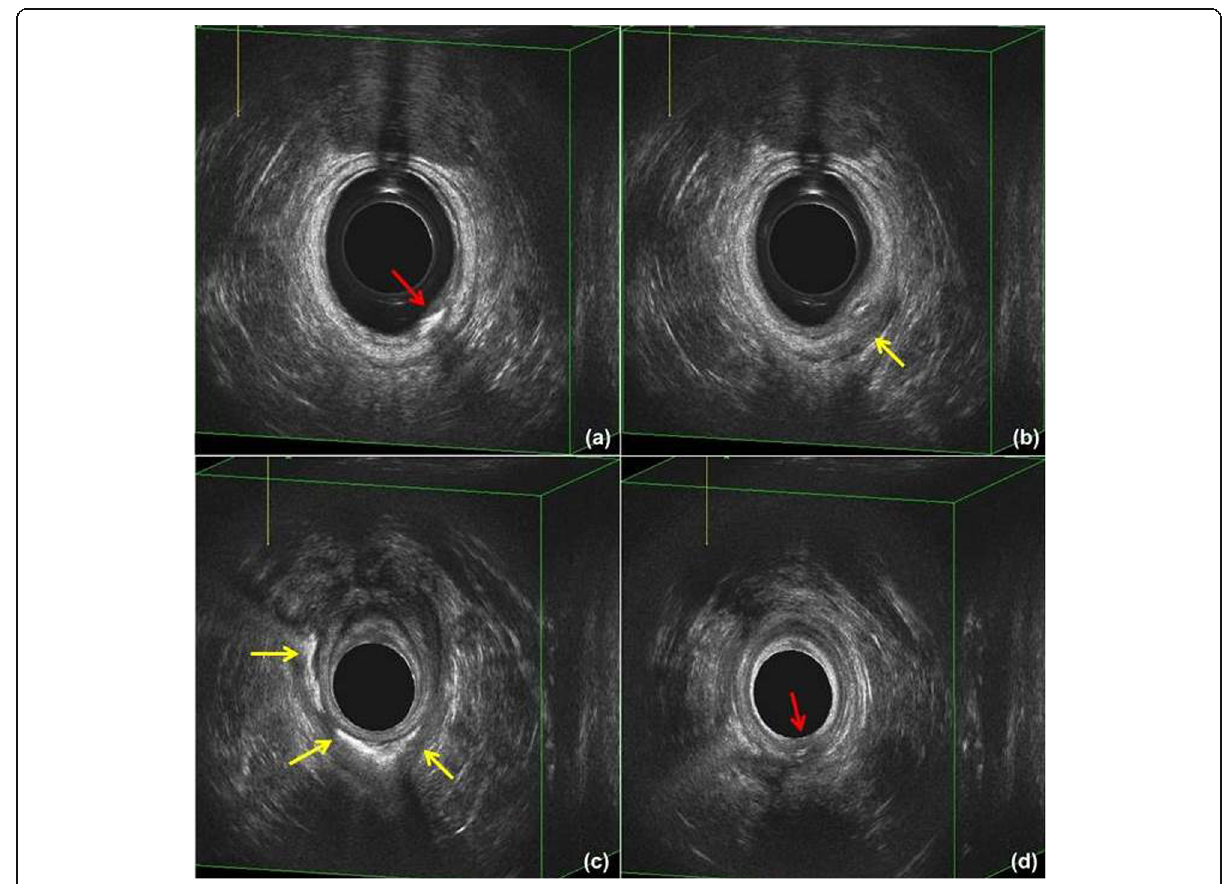
Fig. 8 H 2 O 2 -enhanced 3D TRUS images of transsphincteric fistula with bilateral intersphincteric extension with two internal openings. a Red arrow demonstrates the secondary internal opening as a breach in the continuity of the epithelial layer of the rectum at the posterolateral wall b and c . The course of track shown as a hyperechoic shadow d . The red arrow demonstrates the primary internal opening inside the anal canal as a breach in the continuity of the epithelial layer at mid anal canal